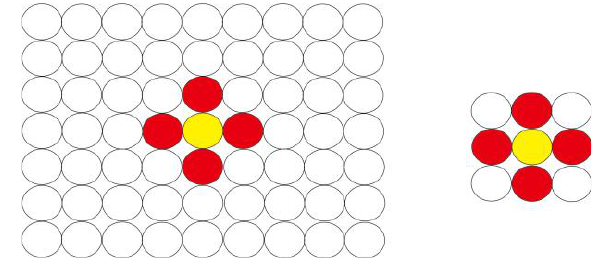
Figure 1. Coordinate neighborhood